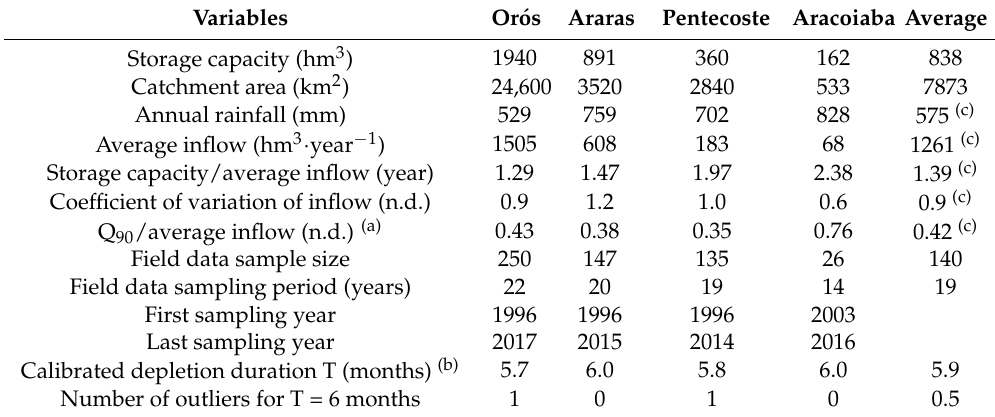
Table 1. Main variables of the four focus reservoirs. the data for each field represent a pair, composed of the measured released discharge and the respective reservoir volume on the same day.